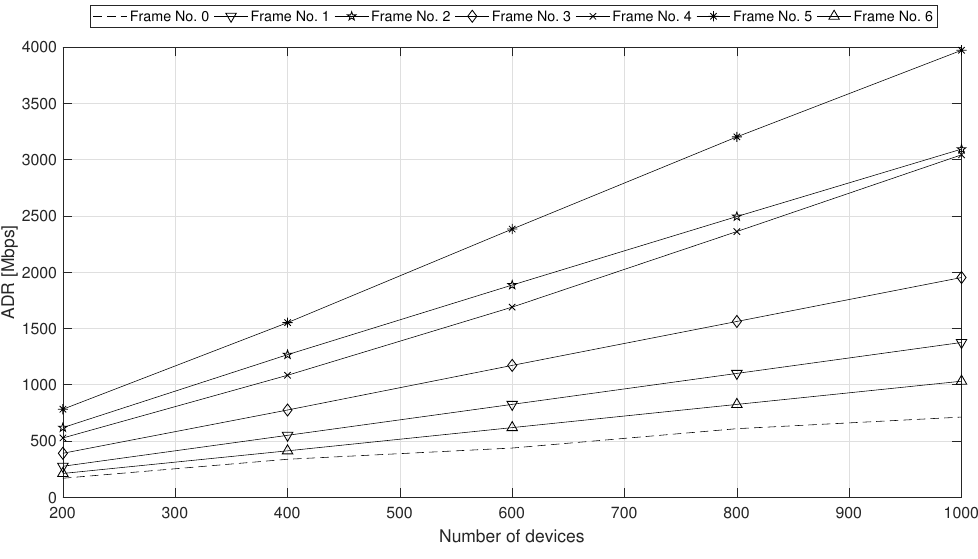
Figure 6. Network Energy Efficiency under increasing number of multicast MTC devices.